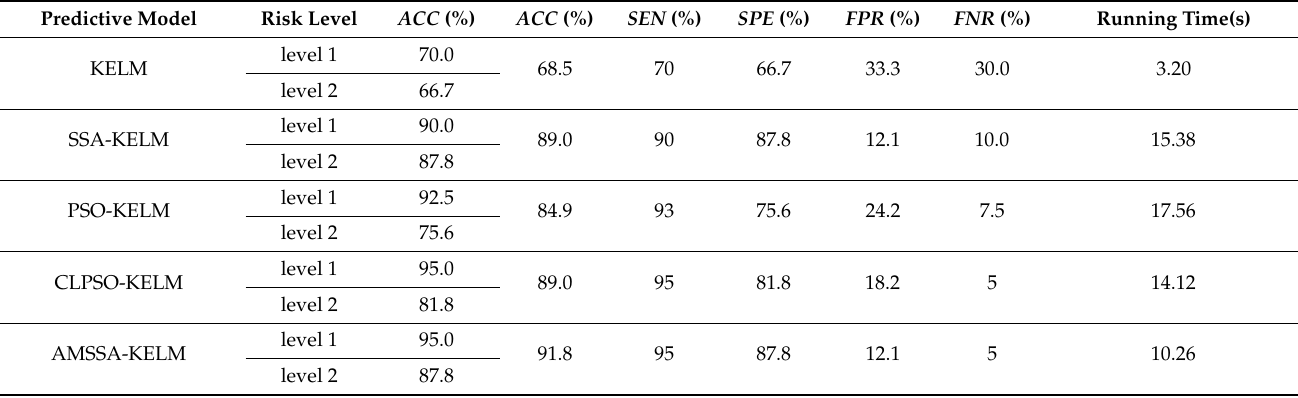
Table 4. Optimization results of different optimization models. SEN: Number of correct and positive validation predictions, as a percentage of positive numbers. SPE: The number of predictions that are negative and correct, as a percentage of the actual total number of negative purposes. FPR: False-positive rate. FNR: False-negative rate.